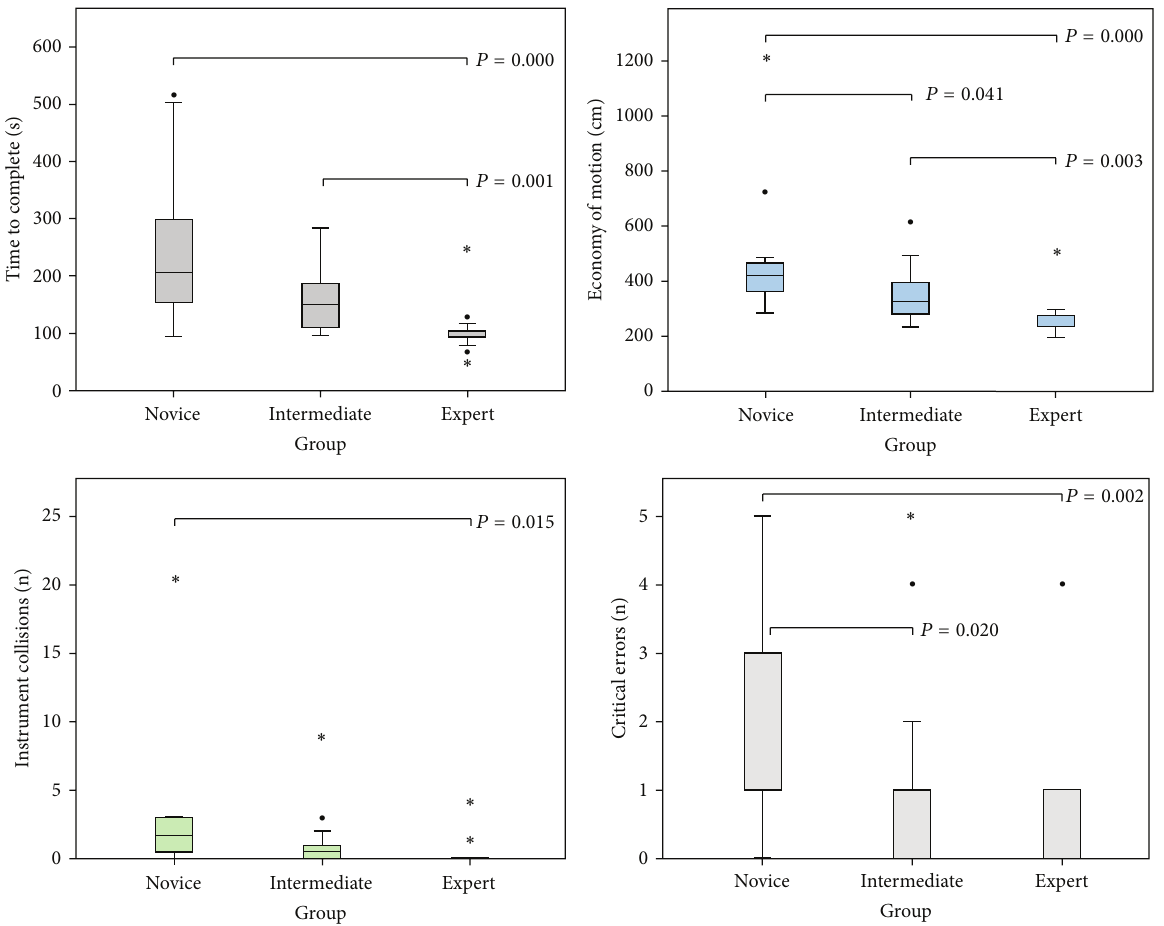
Figure 3: Exercise “Camera Targeting” (box plot of the four most important parameters in the exercise (bars are medians, boxes show inter quartile range, whiskers show range, ∙ are outliers, ∗ are extreme outliers, and large horizontal bars indicate statistically significant differences, specified with 𝑃